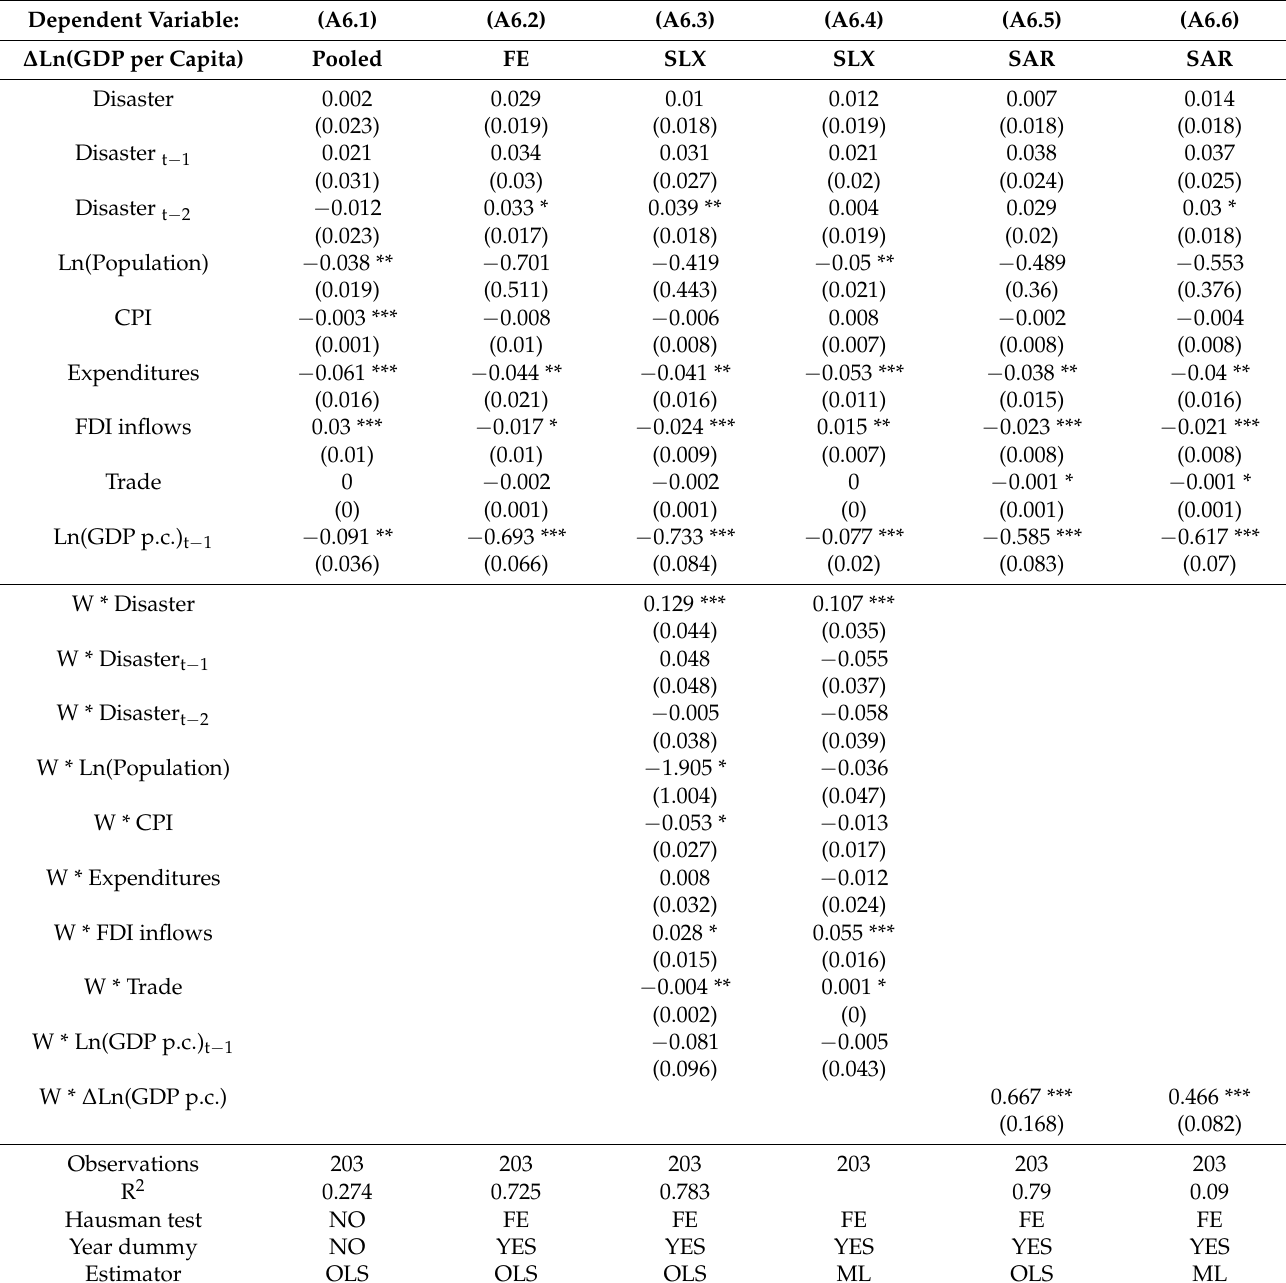
Table A6. Comparison of different spatial panel models (OLS, SLX, and